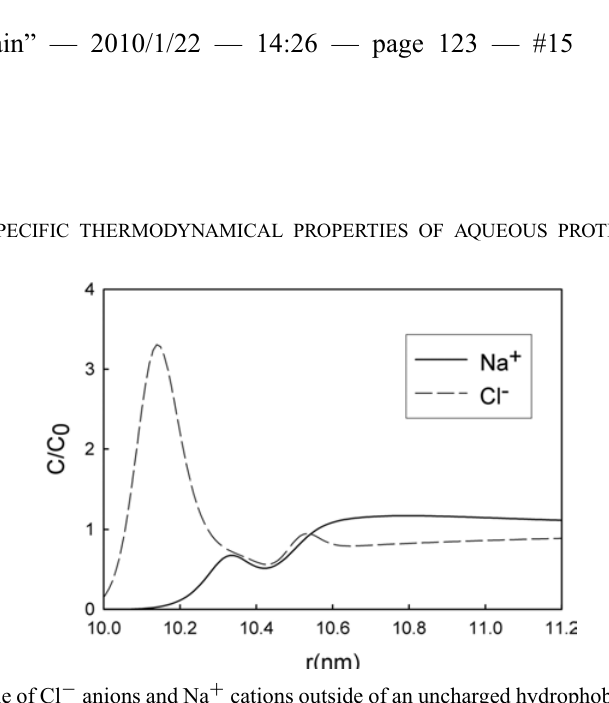
Fig. 10 – Concentration profile of Cl − anions and Na + cations outside of an uncharged hydrophobic colloidal particle with radius 10 nm at a bulk concentration C 0 = 0 . 2 M of